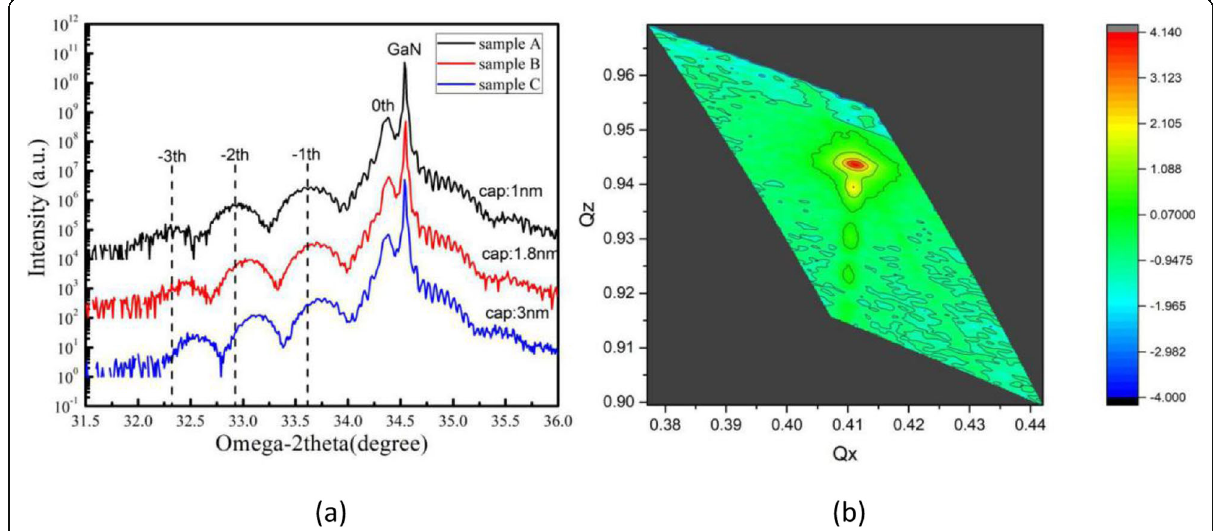
Fig. 1 a XRD ω -2 θ scan curves on GaN (0002) plan for samples A, B, and C. b Reciprocal space mapping of sample